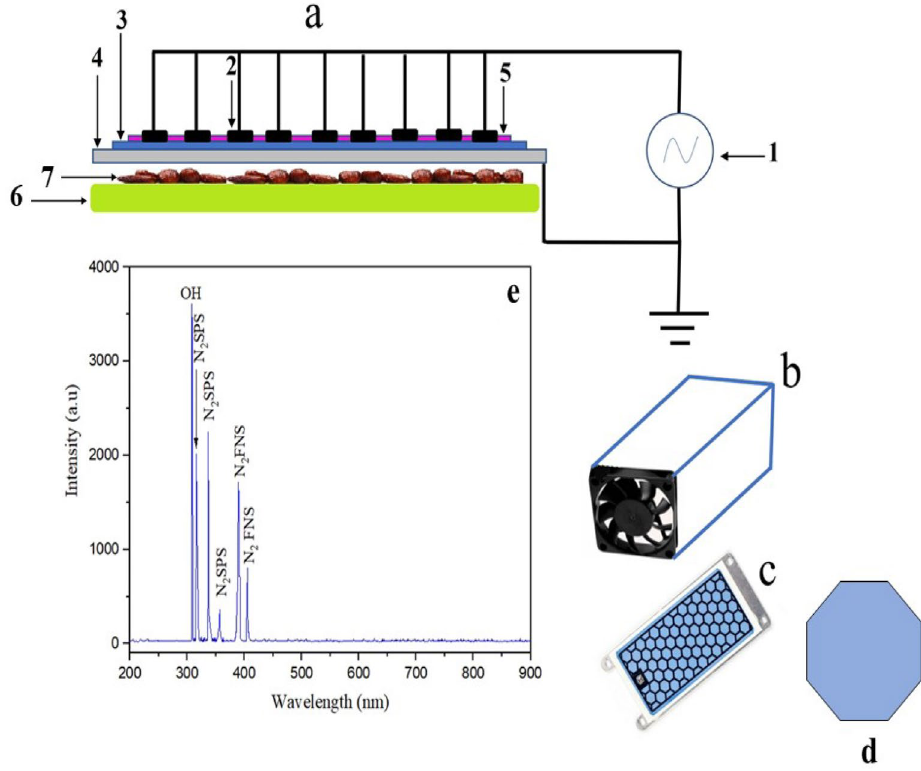
Figure 1. SDBD electric circuit (a); [Power supply (1), HV electrode(2), Dielectric barrier (3), Ground electrode (4), Plasma (5), Sample holder (6) Palm date samples (7)], Teflon box contains the SDBD system (b), honeycomb geometry of SDBD (c), the cell geometry of honeycomb (d), and the emission spectrum of the plasma from SDBD in the range of (200–900 nm)